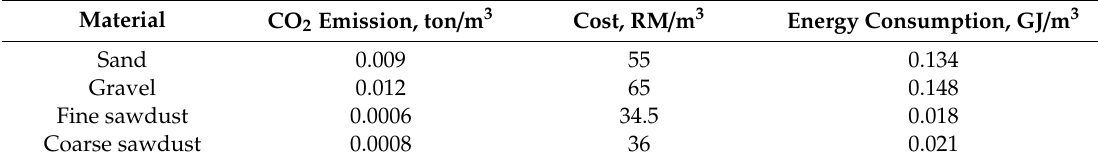
Table 4. The CO 2 release, expenditure, and energy use of every material depended on life